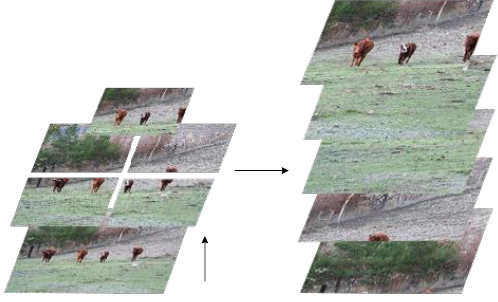
Figure 2. Multi-view segmentation.